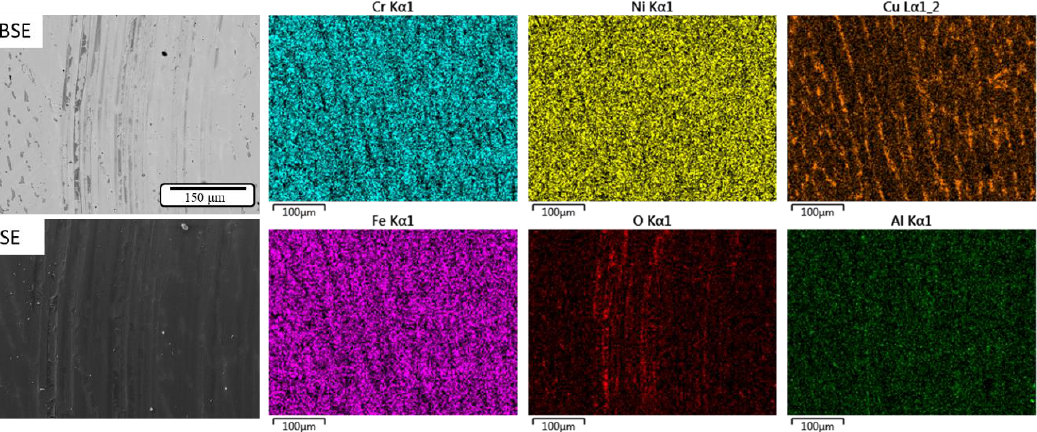
Figure 5. BSE and SE images and corresponding EDS elemental maps of the A2 alloy wear track after RT sliding. RT